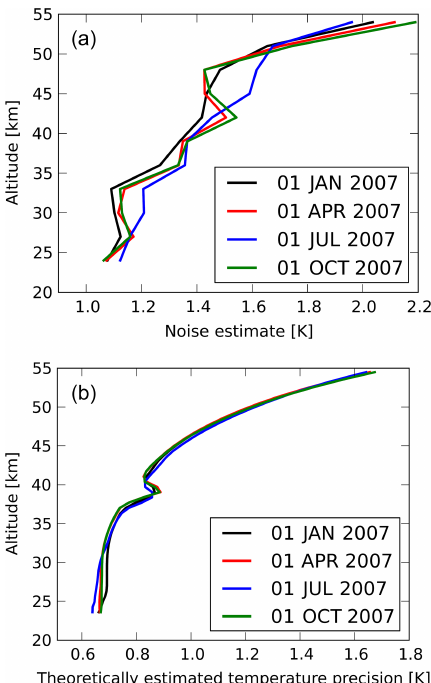
Figure 2. Estimated global mean noise profiles for AIRS (a) and HIRDLS (b)